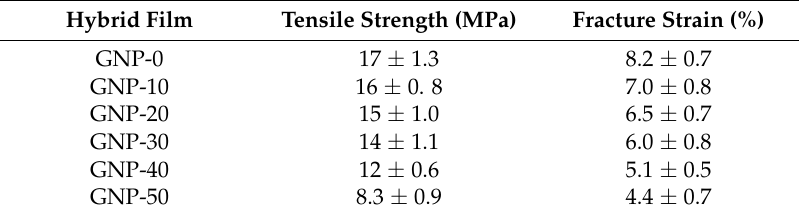
Figure 3. Stress-strain curves of the hybrid films with different weight percentage of graphene nanoplatelets (GNP). Table 1. Mechanical properties of the hybrid film with different weight percentage of graphene nanoplatelets